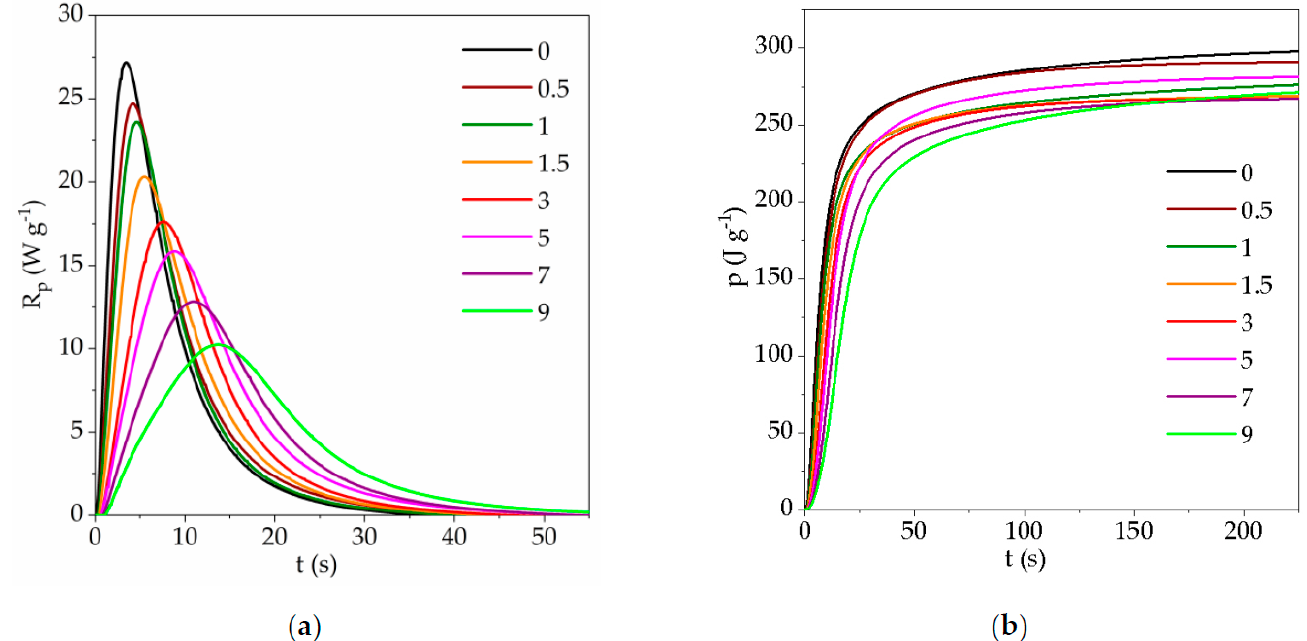
Figure 6. Photo-DSC kinetic curves ( a ) R p = f ( t ), and ( b ) p = f ( t ) for TATT+PETMP+8M-POSS system. Numbers indicate the 8M-POSS content in the compositions, expressed in wt.%.